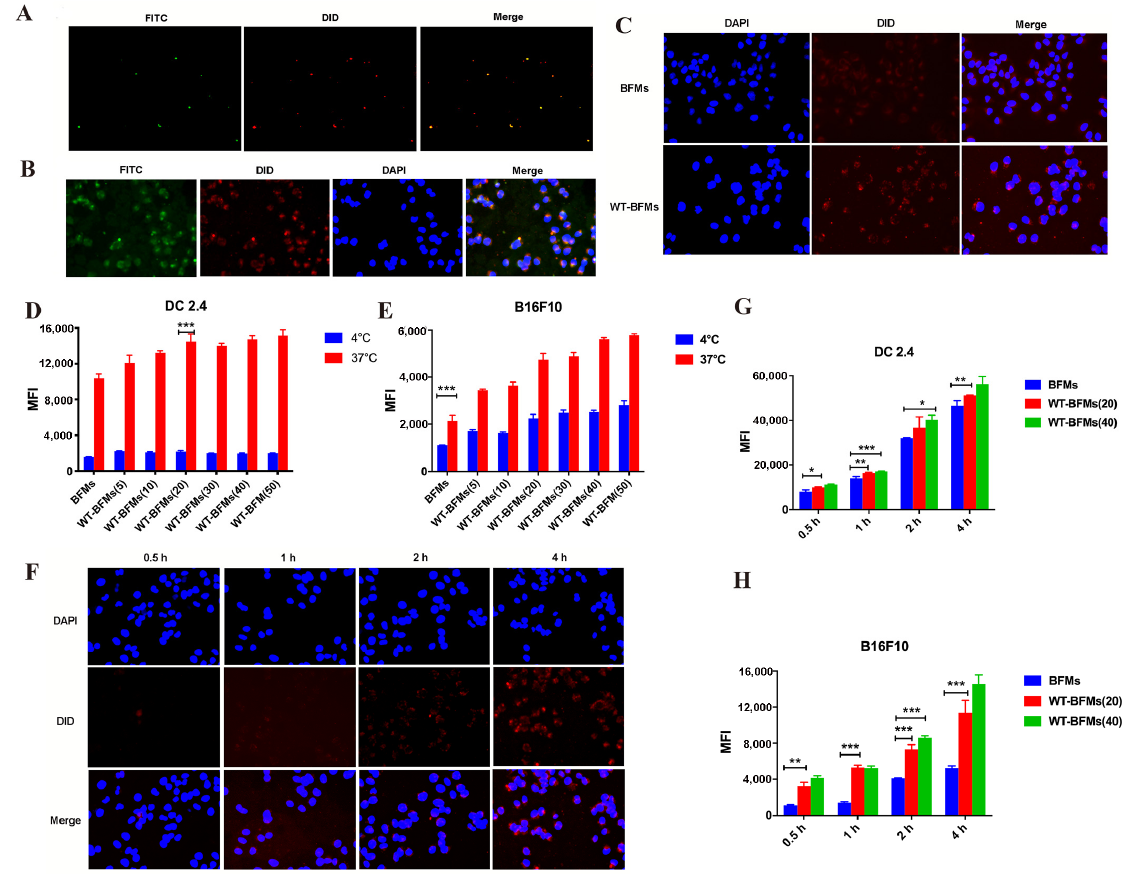
Figure 3. Colocalization of the FITC-WT and BFMs and uptake of BFMs and WT-BFMs in DC 2.4 cells and the cellular uptake efficiency and mechanism of WT-BFMs in DC 2.4 cells. ( A , B ) Colocalization of the BFMs (red channel) and the FITC-WT (green channel) observed by fluorescence microscope. ( C ) The uptake of BFMs and WT-BFMs in DC 2.4 using fluorescence microscope. BFMs were labeled with DiD (red channel) and cell nucleus were labeled with DAPI (blue channel). ( D , E ) The uptake of BFMs and WT-BFMs at a different temperature (4 °C and 37 °C) or at a different ratio of BFMs and WT. ( F ) The uptake of WT-BFMs in DC 2.4 using fluorescence microscope. BFMs were labeled with DiD (red channel) and cell nucleus were labeled with DAPI (blue channel).( G , H ) The uptake of BFMs and WT-BFMs in DC 2.4 and B16F10 for 0.5 h, 1 h, 2 h, 4 h (of which the final concentration of WT was 20 μ g/mL,40 μ g/mL). Data are mean ± SD (n = 3). *** p < 0.001, ** p < 0.01, * p < 0.05.